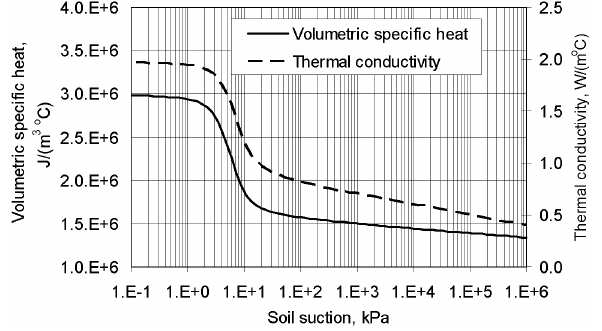
Figure 2a. Hydaulic properties of the Beaver Creek sand (Gitirana et al. 2005)